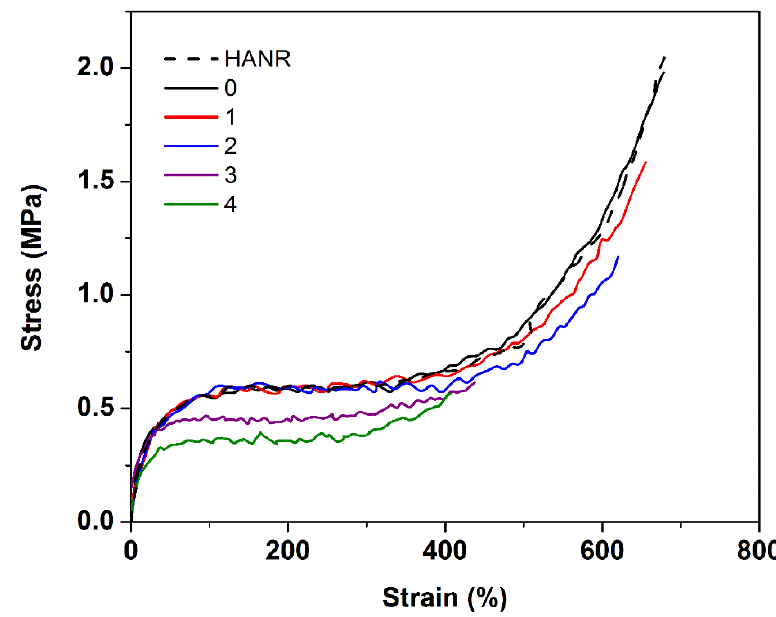
Figure 5. Representative stress-strain curves of HANR and DPNRs.